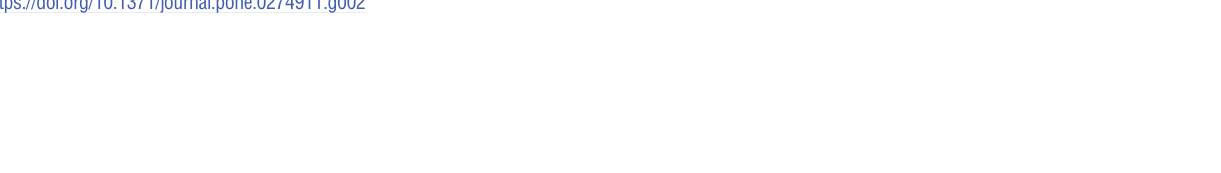
PLOS ONE | https://doi.org/10.1371/journal.pone.0274911 September 29, 2022 5 /